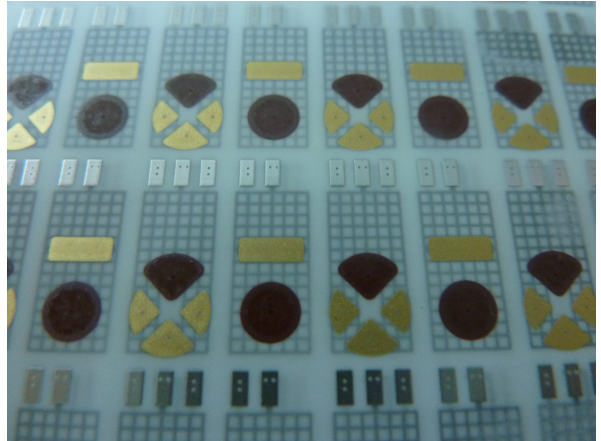
Figure 5. HTCC multilayer in multiple use with sensor array vari- ant 1 (triangular-shaped pH electrode and three other ISEs) and vari- ant 2 (circular-shaped pH electrode and another ISE) on the top.